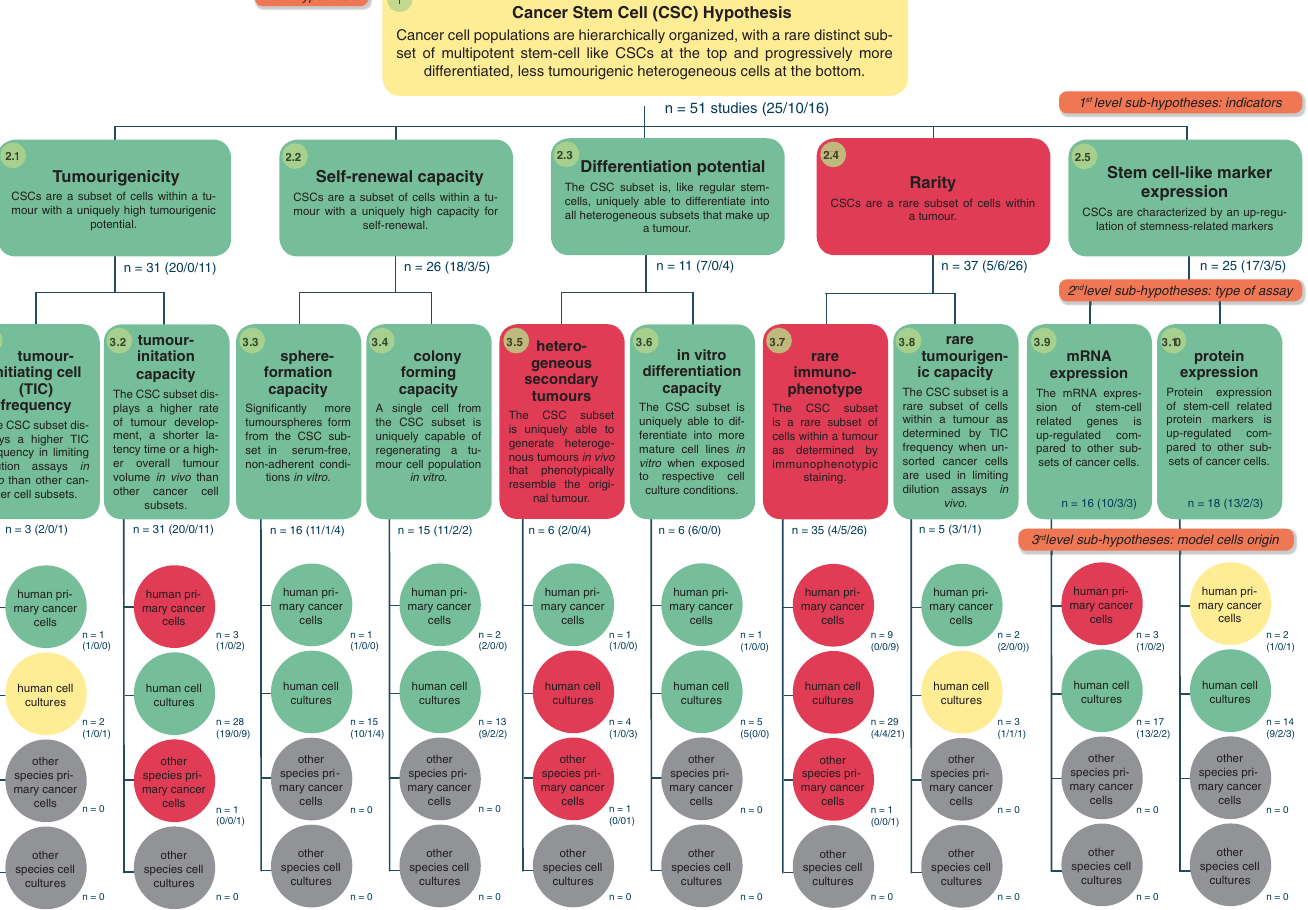
Fig 1. Hierarchy-of-hypotheses for the Cancer Stem Cell (CSC) hypothesis. The sub-hypotheses were defined by classifying the evidence on three levels: (1) indicators assessed to test the existence of CSCs, (2) experimental assay and (3) model cancer cells used. The empirical tests of analysed 51 studies were sorted into the HoH. Green indicates that more than 50% of the studies supported the sub-hypothesis; red indicates that more than 50% questioned the sub-hypothesis; yellow indicates sub- hypotheses for which neither supporting nor questioning evidence reached 50%. The number of studies with supporting / undecided / questioning evidence is indicated for each hypothesis in